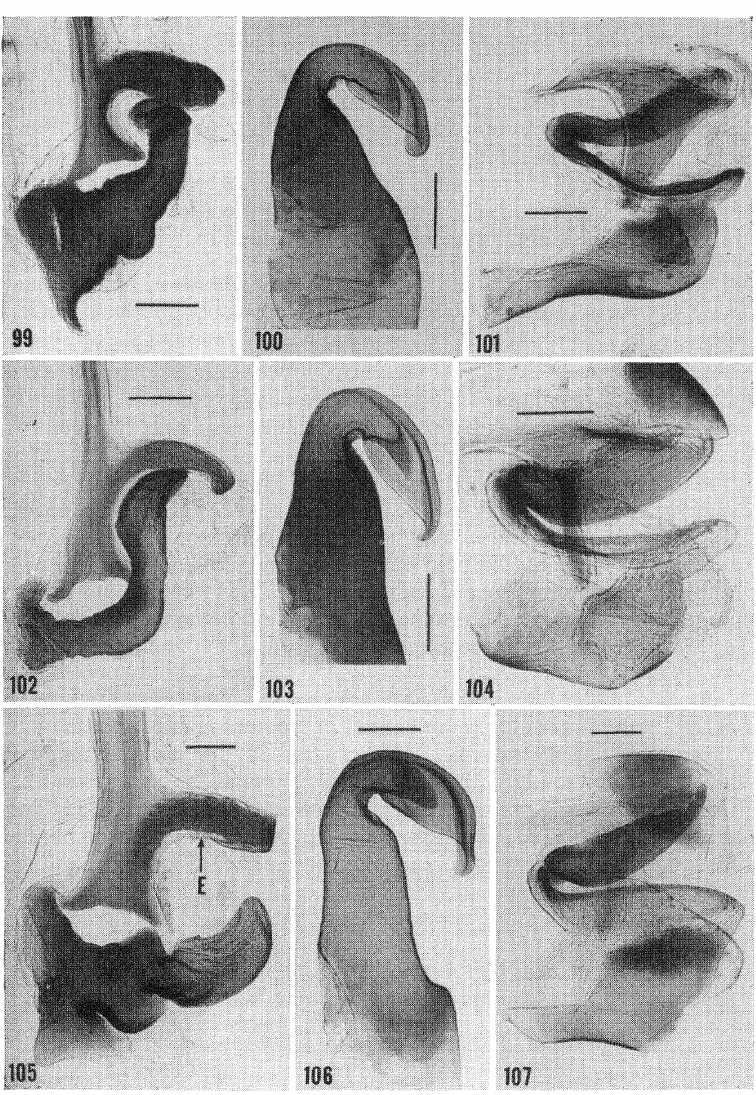
Figs. 99-107. 99-101. (103 ANSP). Tribonium colombicum. (from adult shown in Fig. 19). 102-104. (104 ANSP). Tribonium consIersum (from adult shown in Fig. 18). 105-107. (1 CUZM). Tribonium sp. E dorsal extension o L2vm. (seale 0.2